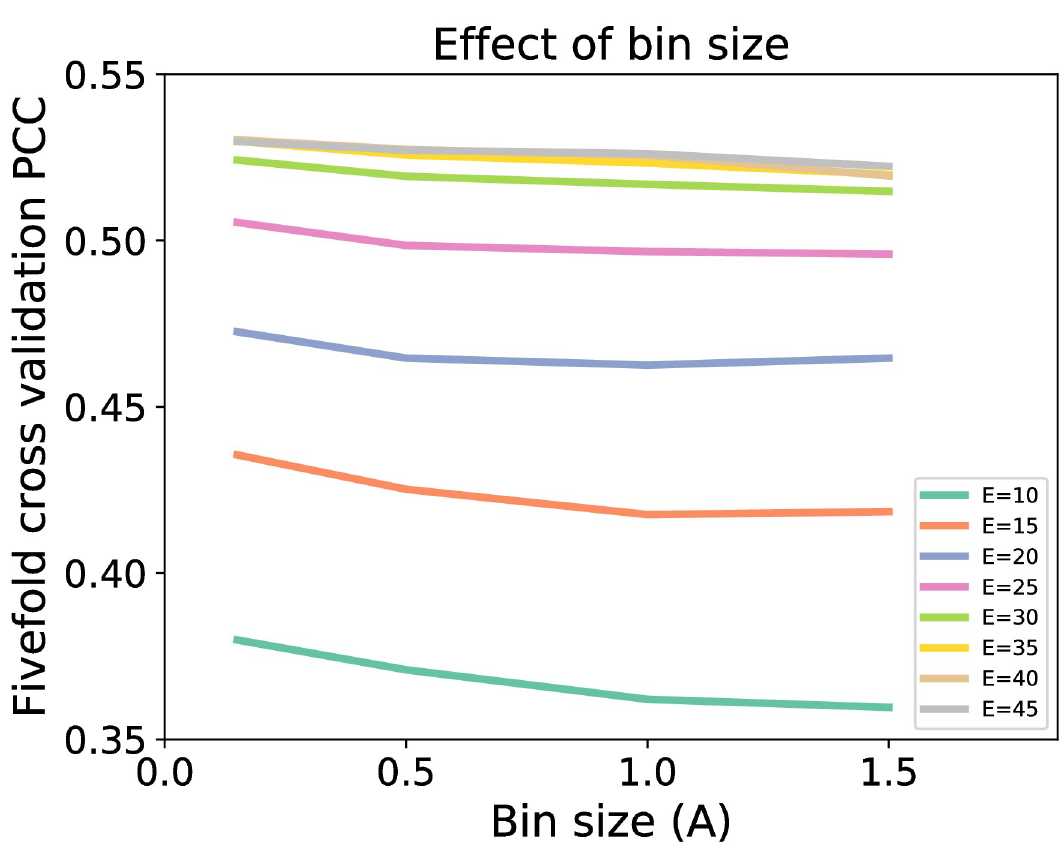
Fig 4. Effect of bin size on RF performance with a fixed F/E ratio of 1.0. S1 Table. PCC of each RNA chain in training set achieved by the best optimal RF. (PDF) S2 Table. PCC of each RNA chain in test set achieved by the best optimal RF. (PDF)